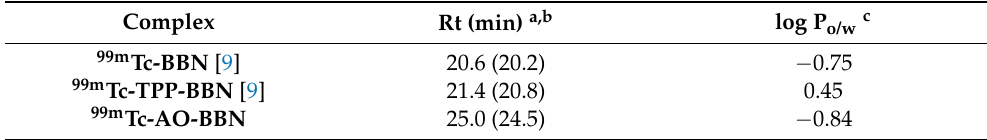
Table 1. Radio-HPLC retention times and log P o/w values at pH 7.4 for complexes 99m Tc-BBN, 99m Tc-TPP-BBN and 99m Tc-AO-BBN .